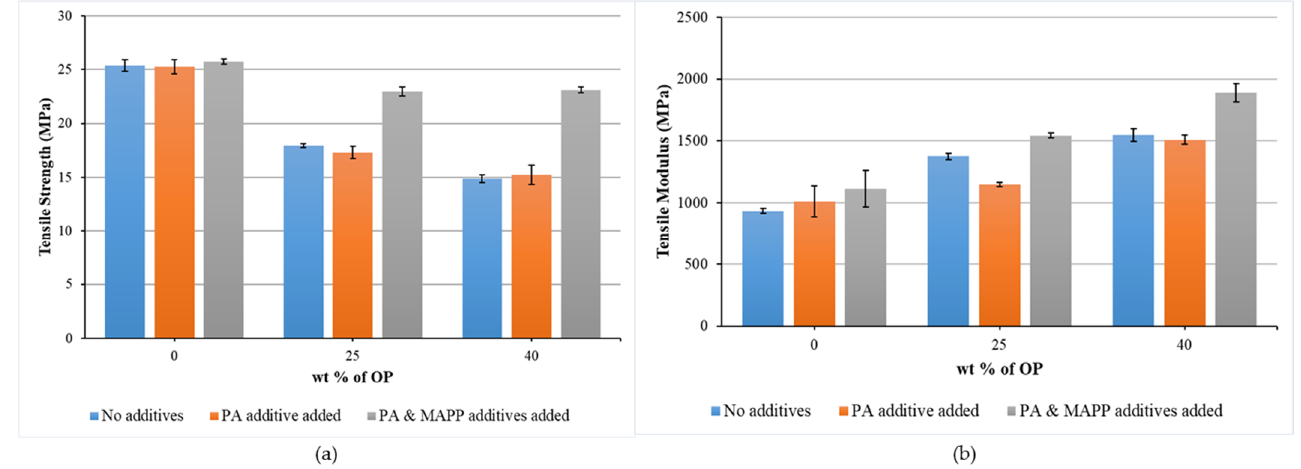
Figure 7. Tensile strength ( a ) and tensile modulus ( b ) of biocomposites as a function of percentage by weight of OP, considering materials without additives, adding PA and adding PA and MAPP, respectively.